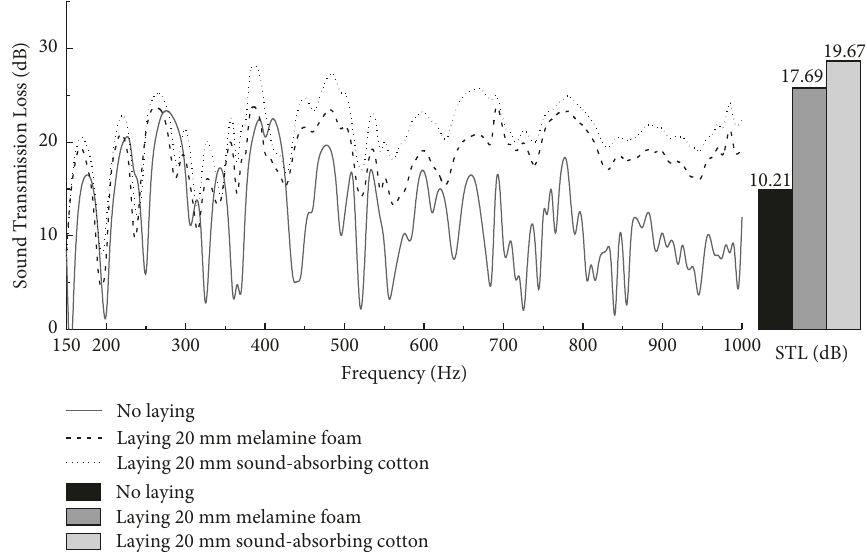
Figure 8: Comparison of laying the same thicknesses of acoustic material for the sound transmission loss of the cylindrical shell.